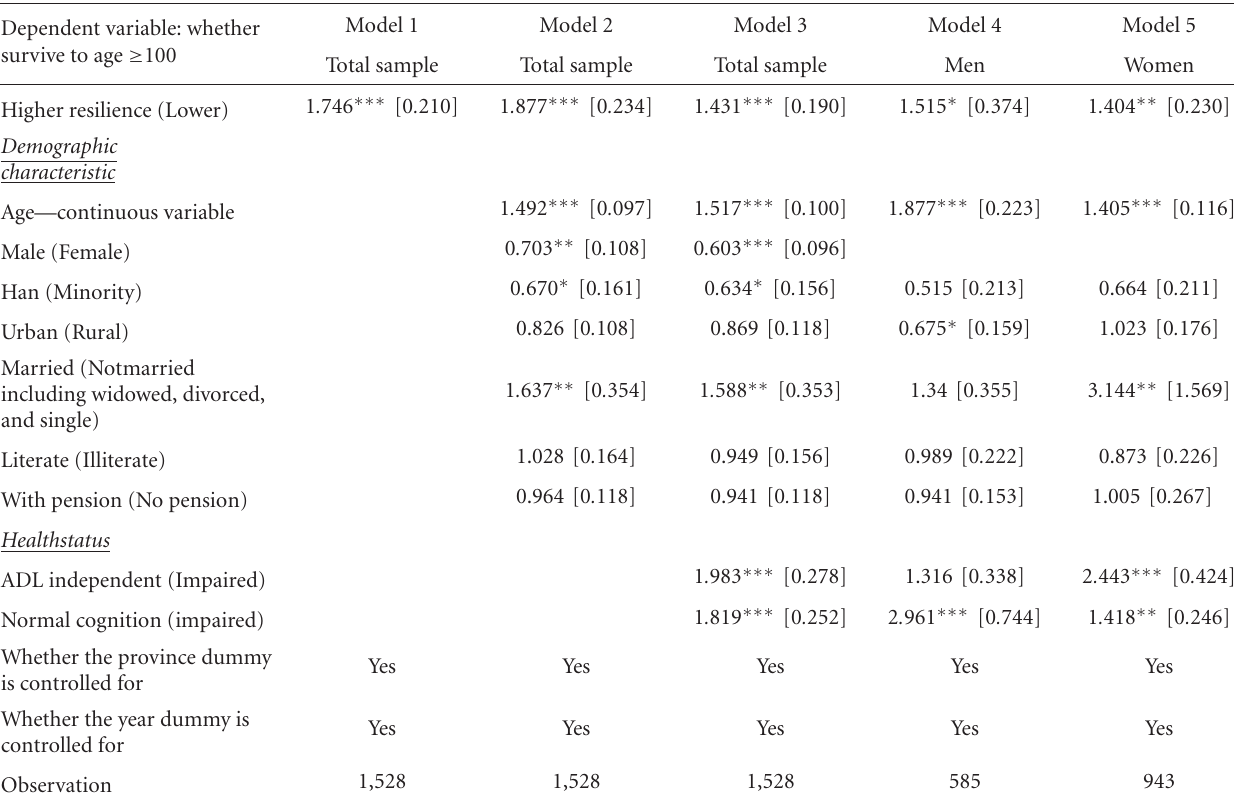
Table 5: Odds ratios of the impact of the resilience on nonagenarians’ likelihood to become a centenarian based on multivariate logistic